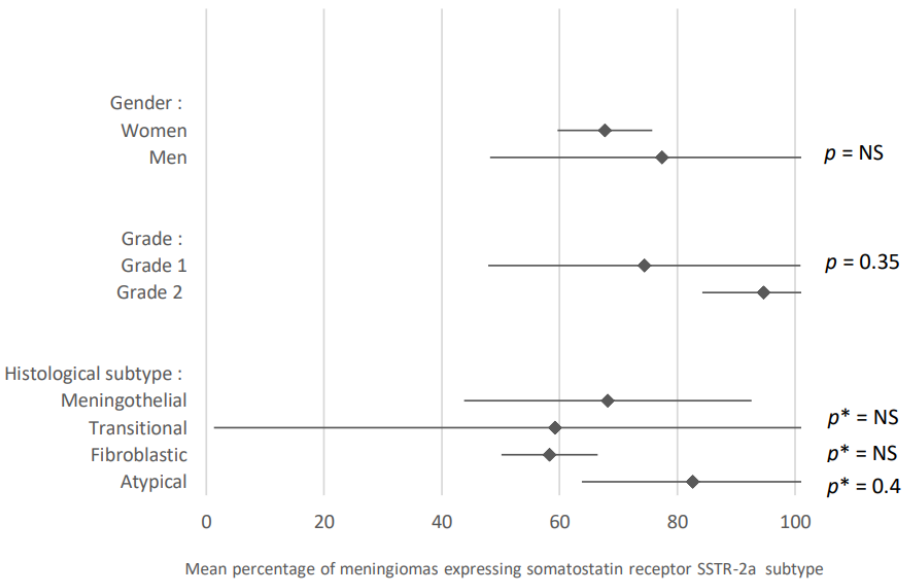
Figure 14. Comparison of somatostatin receptor SSTR-2a subtype expression in meningiomas according to different parameters. The results are expressed as a mean associated with their 95% confidence interval. p *: meningothelial subtype versus other subtypes. NS: not significant. Number of articles analyzed related to the topic for each parameter: Gender: 2; Grade: 3; Histological subtype: 3. Number of included cases (total for all studies; minimum; maximum in each study): Gender: Women, 54 (22; 32)/Men, 21 (8; 13); Grade: Grade 1, 99 (13; 47)/Grade 2, 31 (1; 19) Histological subtype: Meningothelial, 47 (7; 29)/Transitional, 27 (1; 16) / Fibroblastic, 26 (2; 16); Atypical, 29 (3; 16).